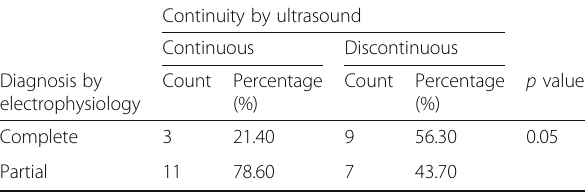
Table 7 Diagnosis of nerve injury by electrophysiology and by